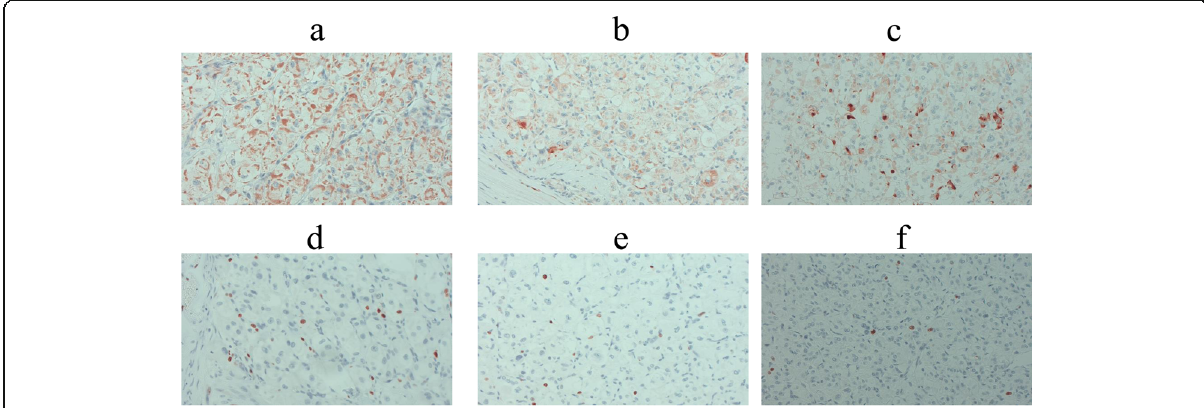
Fig. 4 Immunohistochemistry analysis in primary ASPS, and pancreatic and splenic metastases (Desmin and Ki-67 original magnification x 200). Primary ASPS ( a ), pancreatic metastases ( b ), and splenic metastases ( c ) had Desmin-positive foci. The antigen Ki-67 proliferation index was < 10% in primary ASPS ( d ), pancreatic metastases ( e ), and splenic metastases ( f